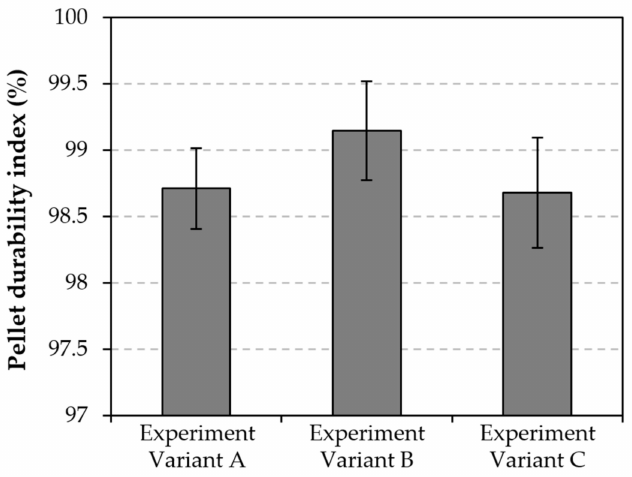
Figure 12. PDI values comparison before and after cooling for variants